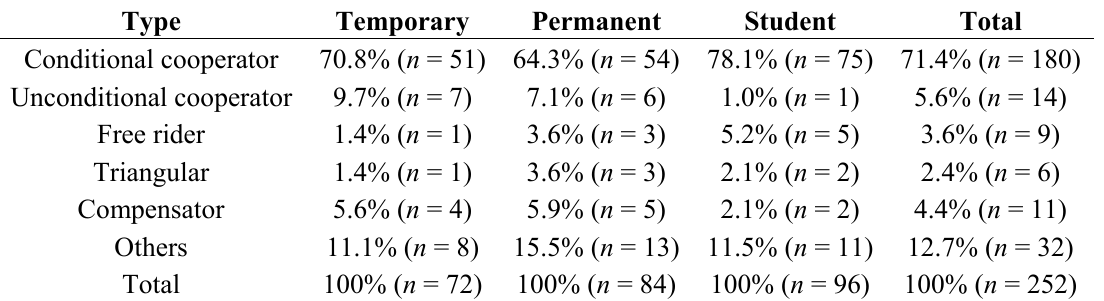
Table 3. Classification of types in the three samples (Strategy